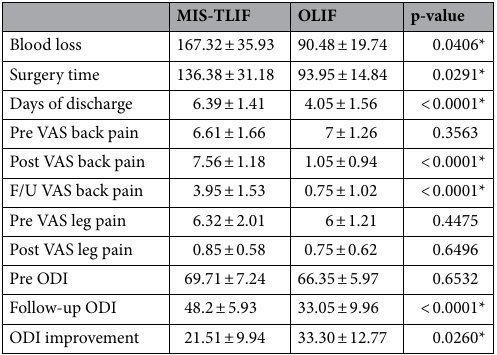
Table 2. Perioperative and clinical outcomes. Values are mean ± standard deviation; ODI: Oswestry Disability Index; VAS: visual analogue scale; Post: pos-operative (3 days after surgery); F/U: follow-up (6 months after surgery). *p < 0.05, statistical significance.